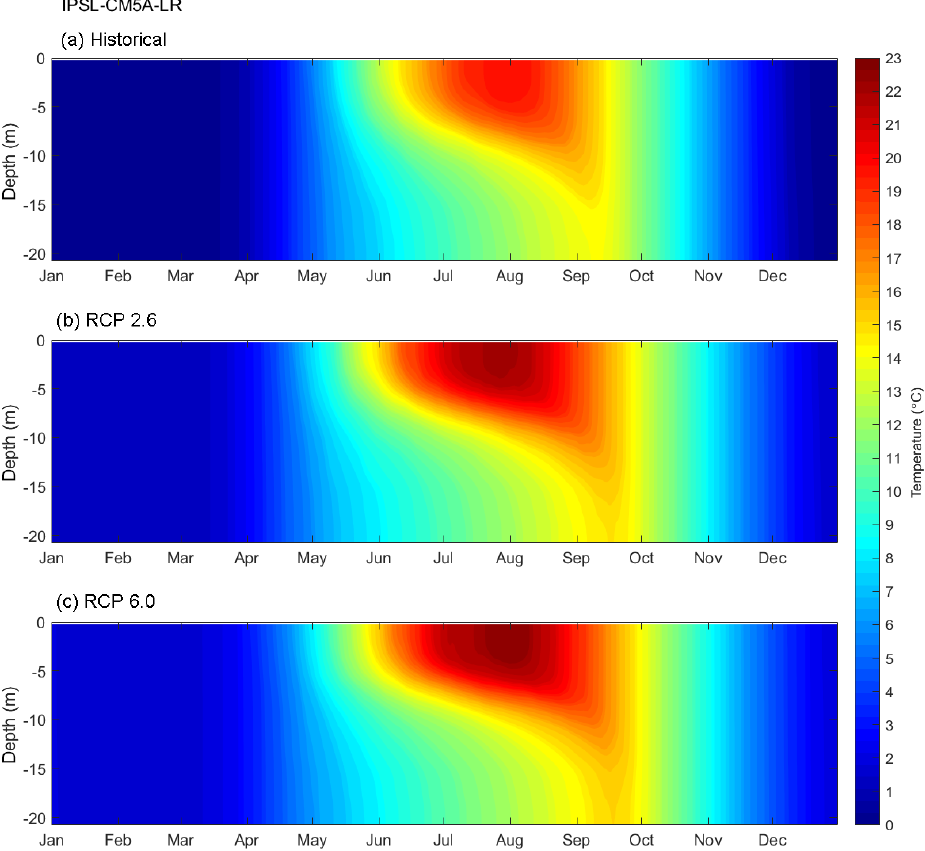
Figure 3. Temperature isopleth diagrams for the (a) historical, (b) RCP2.6, and (c) RCP6.0 scenarios and showing results from the lake model forced with daily IPSL–CM5A–LR projections. The temperature matrix used to make these plots was created by averaging the simulated daily temperature profiles for every year in each